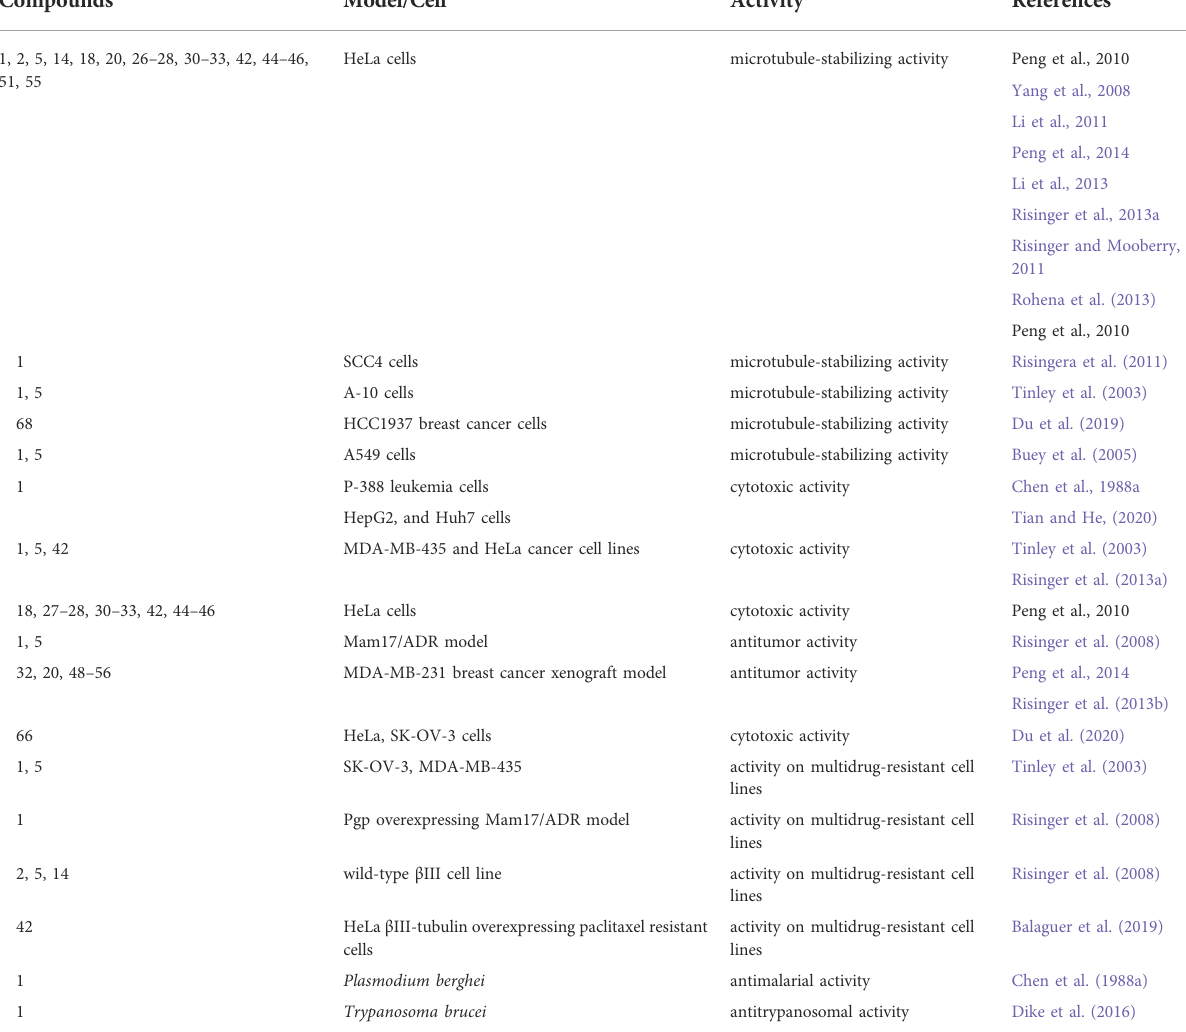
TABLE 2 The biological activity of taccalonolides in this review.